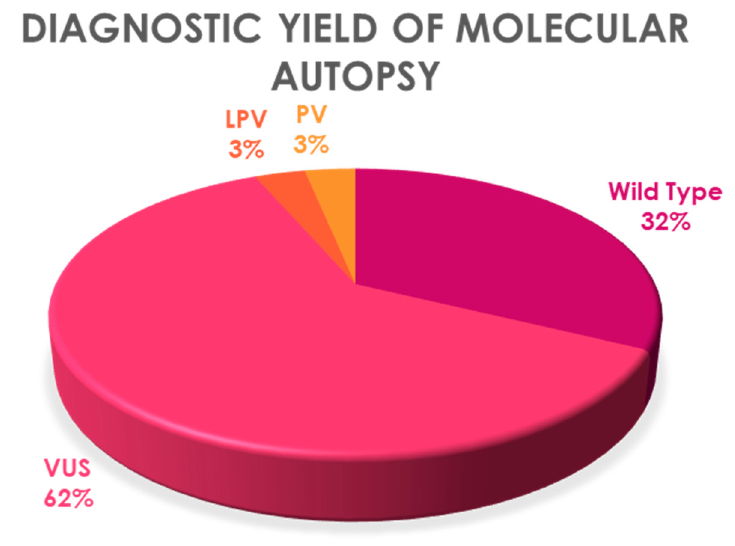
Figure 3. Molecular autopsy results. VUS, variant of unknown significance; PV, pathogenic variant; LPV, likely pathogenic variant.